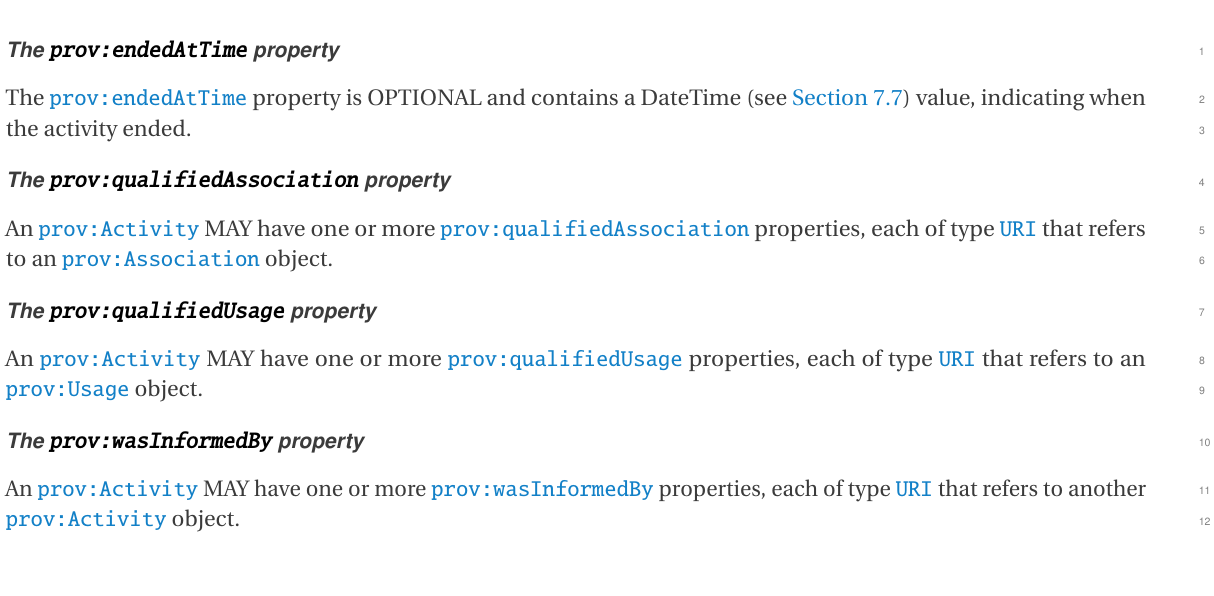
Figure 27: Relationships between SBOL and PROV-O classes. The PROV-O classes prov:Activity , prov:Plan , and prov:Agent all derive from TopLevel in the context of the SBOL data